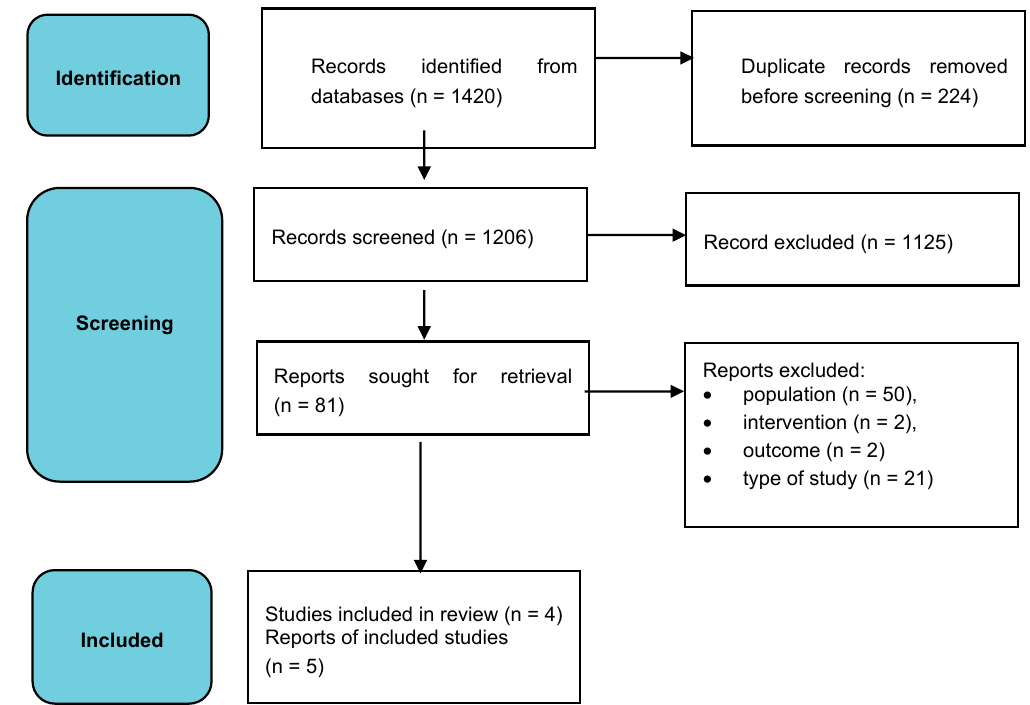
Figure 1. Prisma fl ow diagram. Figure 1. Prisma flow